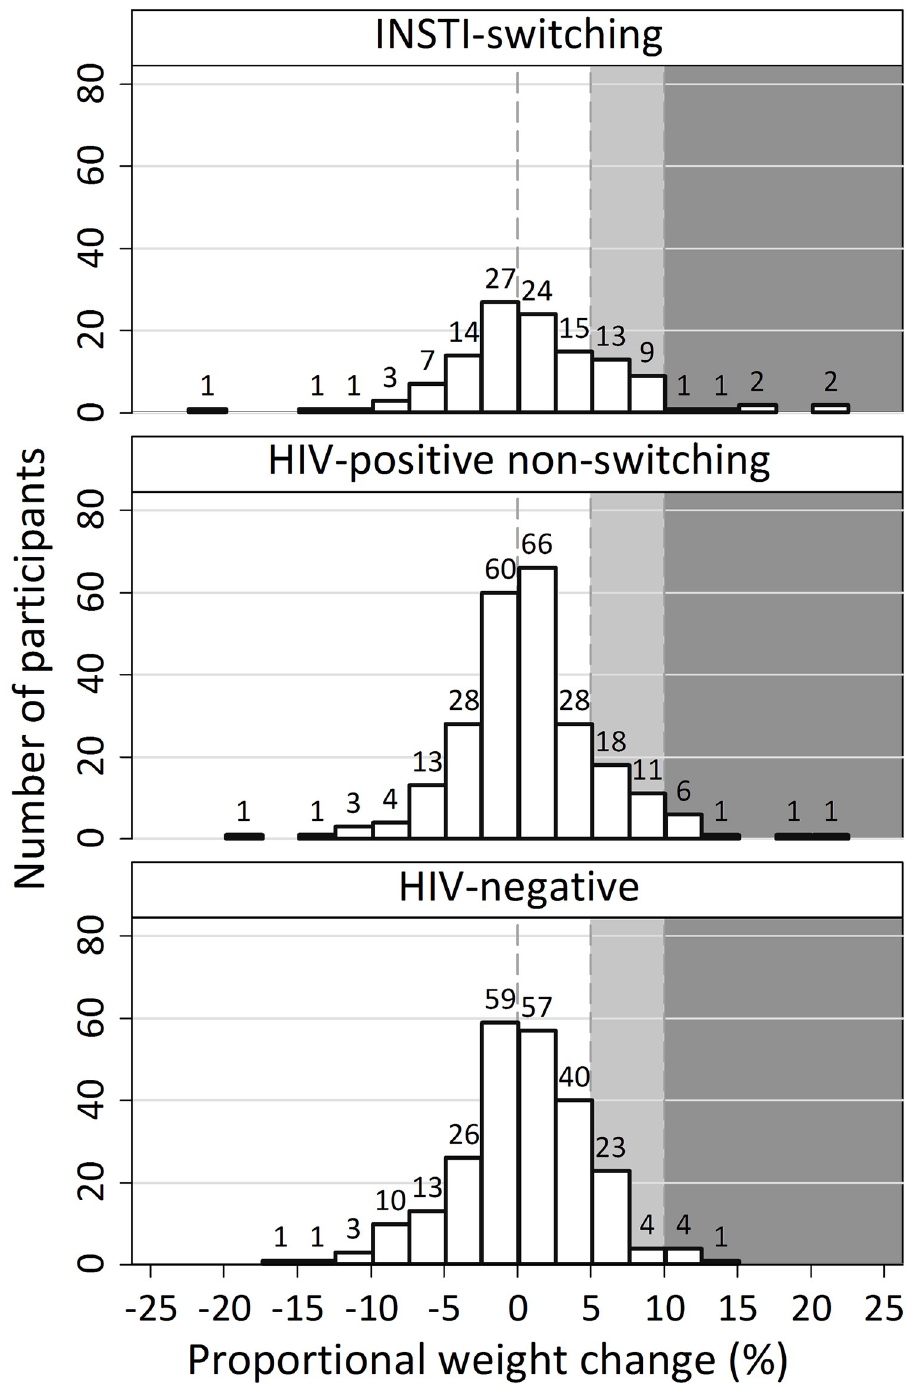
Fig 2. Proportional weight change at first visit after baseline compared to last visit before baseline. Change compares the first weight measurement after baseline with the last weight measured prior to baseline. Light and dark grey fields indicate participants with a proportional weight increase of > 5% (light + dark grey) and > 10% (dark grey). Numbers above bars indicate absolute number of participants per bin.